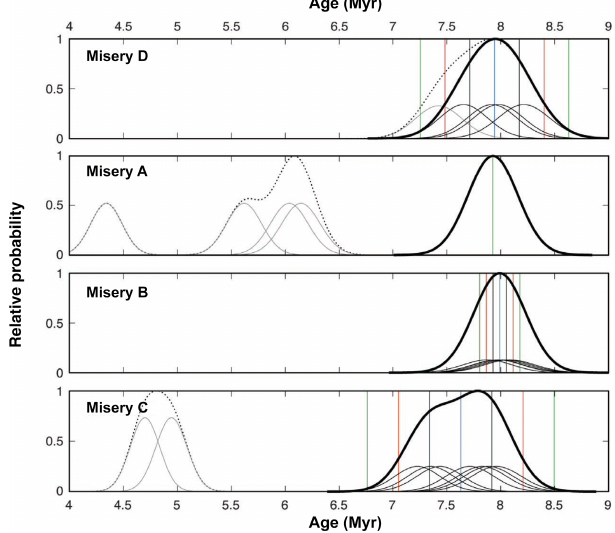
Figure 13. Camel plots (i.e., normal kernel density functions) for the four Misery moraines. The arithmetic mean of the reduced dataset is denoted by the blue line, while the 1 σ , 2 σ , and 3 σ un- certainty envelopes are shown in black, red, and green, respectively. Dotted black lines show the summed probability distributions for the full dataset, including outliers shown in gray, while the thick black lines show the probability distribution for the reduced